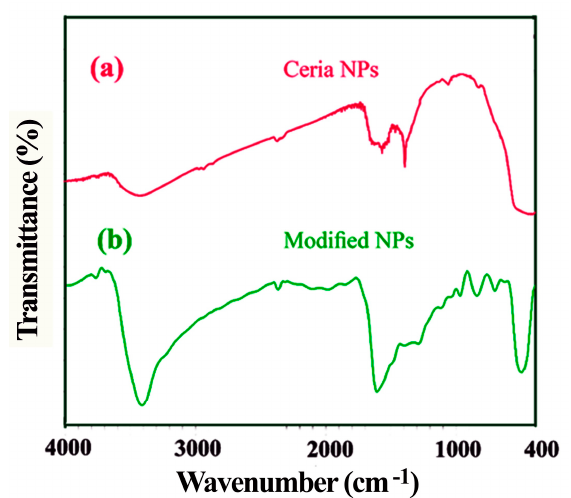
Figure 3. FT-IR spectra of pure CeO 2 and surface modified CeO 2 NPs.